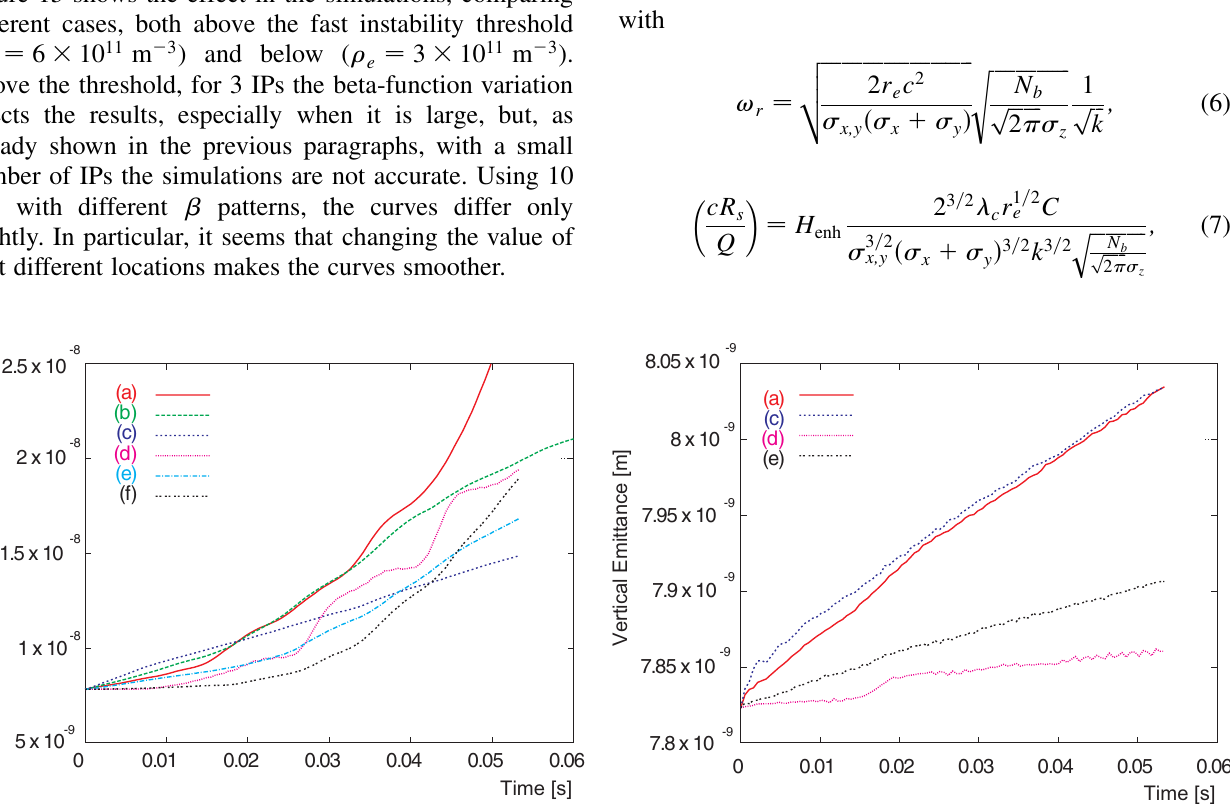
FIG. 15. (Color) Effect of considering different beta values. Vertical emittance as a function of time, with parameters of LHC at (cid:2) 6 (cid:6) 10 11 m (cid:4) 3 (left) and (cid:2) (cid:2) 3 (cid:6) 10 11 m (cid:4) 3 (right). Line (a) refer to simulation with 3 injection and chromaticity Q 0 (cid:2) 2 , for (cid:2) e e (cid:2) 100 ; 40 ; 160 m , (c) is 3 IPs with (cid:3) (cid:2) 100 ; 20 ; 180 m , (d) is 10 IPs, same (cid:3) (cid:2) 100 m IPs, (cid:3) (cid:2) 100 m in each IP, (b) is 3 IPs, (cid:3) y y (cid:2) 100 ; 20 ; 180 ; 100 ; 180 ; 100 ; 20 ; 100 ; 20 ; 180 m , and (f) is 10 IPs but with a different over the entire ring, (e) is 10 IPs, (cid:3) y (cid:2) 100 ; 100 ; 100 ; 180 ; 180 ; 180 ; 100 ; 20 ; 20 ; 20 m . configuration of (cid:3) y